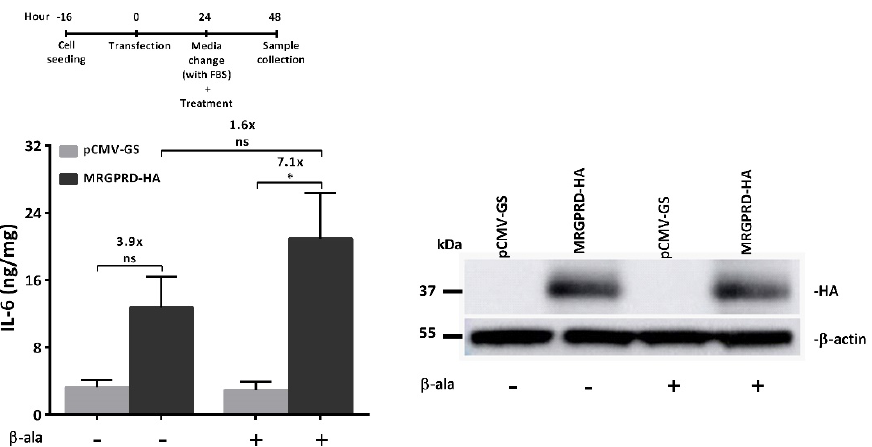
Figure 1. Activation of MRGPRD mediates IL-6 release. HeLa cells transiently expressing empty vector (pCMV-GS) or MRGPRD-HA were stimulated with either vehicle control or β -alanine (100 µ M; final concentration/well). The normalized IL-6 release is represented in ng/mg. β -alanine- or vehicle- treated cells expressing MRGPRD released high and intermittent levels of IL-6, respectively. Whereas vehicle- or β -alanine-treated cells expressing the empty vector did not release significant amounts of IL-6. On the right, a representative Western blot of whole cell lysates from HeLa cells transiently transfected with either empty vector (pCMV-GS) or MRGPRD-HA plasmids is displayed. Expression of the MRGPRD-HA receptor (~37 kDa) was observed in both vehicle and β -alanine (100 µ M)-treated MRGPRD-transfected cells, whereas cells transfected with the empty vector showed no expression (i.e., absence of a protein band of ~37 kDa). The graph represents the mean ± s.e.m values from three independent experiments. Statistical significance was determined using one-way analysis of variance (ANOVA), and Sidak’s post hoc test was applied for multiple comparisons. * p ≤ 0.05 was considered significant and ‘ns’ is